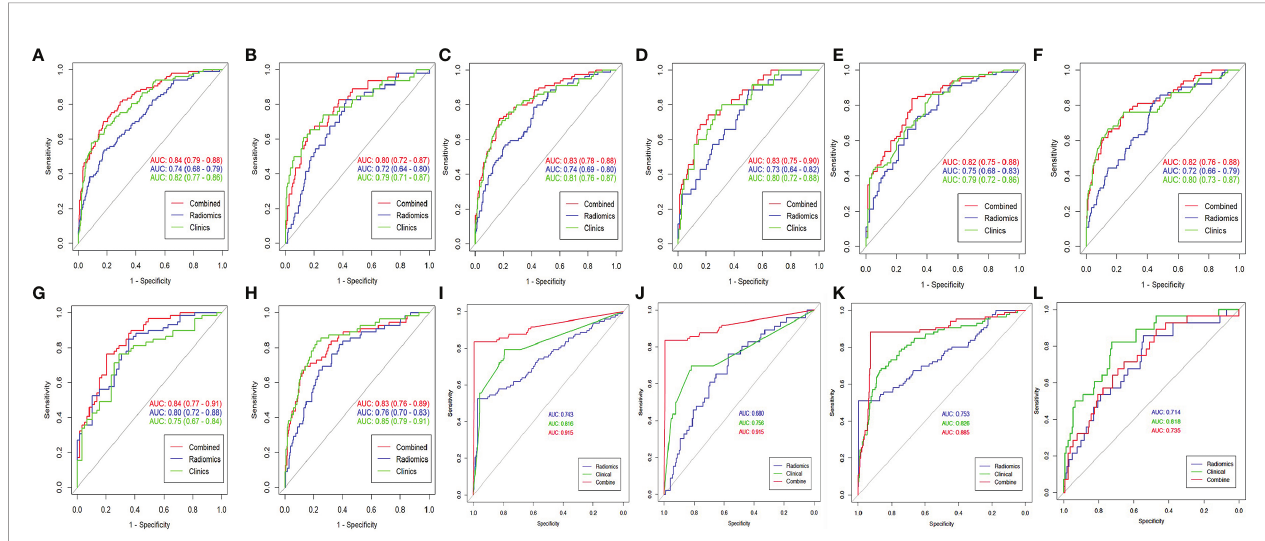
FIGURE 2 | The ROC curve of different models. (A, B) CT-based RN1; (C, D) CTE-based RN1; (E, F) CT-based RN2; (G, H) CTE-based RN2; (I, J) CT-based DNN; (K, L) , CTE-based DNN. Column 1, 3, 5 is the training set, and column 2, 4, 6 is the validation set. The best-performing clinical-DNN based on CT features reached an AUC of 0.915 in both training set and validation set (I, J) .